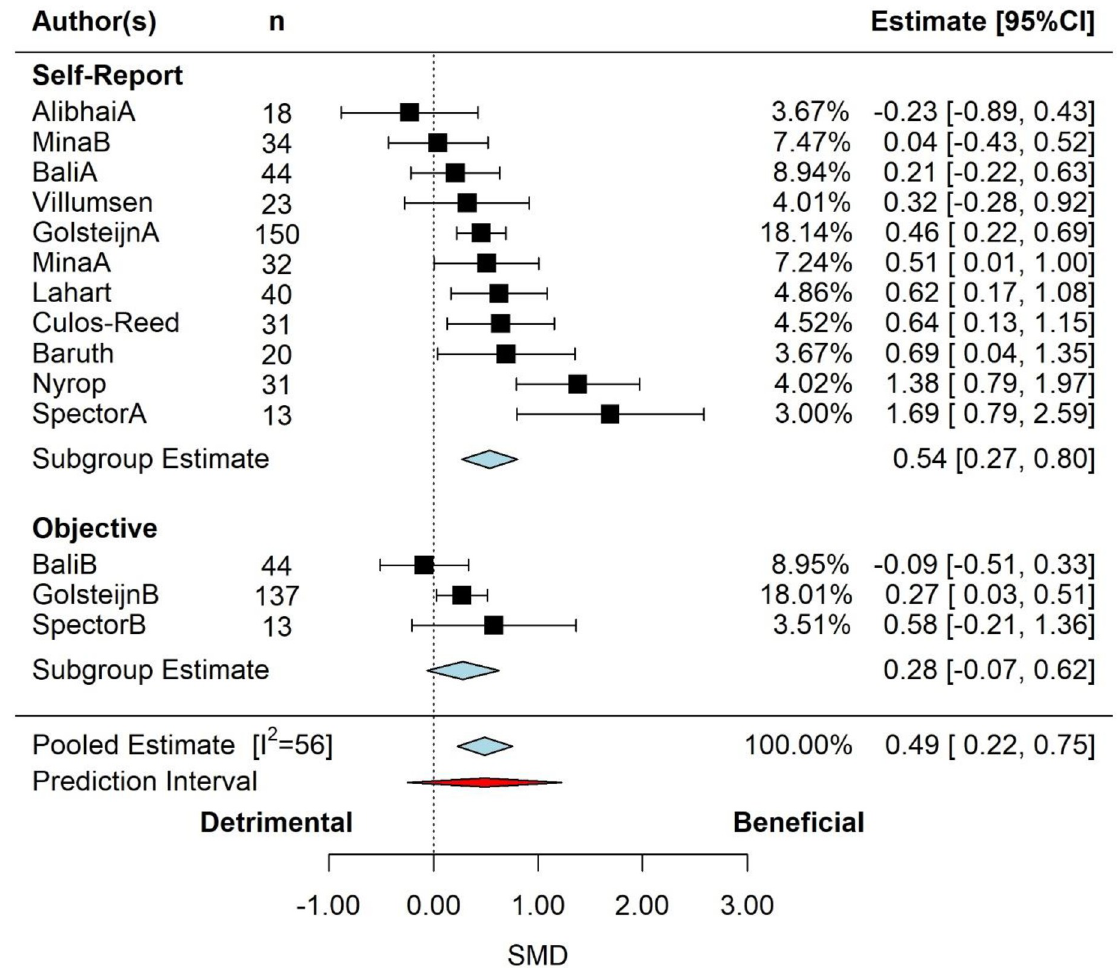
Fig 3. Pooled effect of exercise intervention on incidental physical activity, with sub-group analysis by assessment type (k = 10, u = 14, n = 630). Based on the 3-level model, there was a small but significant effect (SMD = 0.49, 95% CI: 0.22 to 0.75, p < 0.001). Abbreviations : CI, confidence interval; SMD, standardized mean